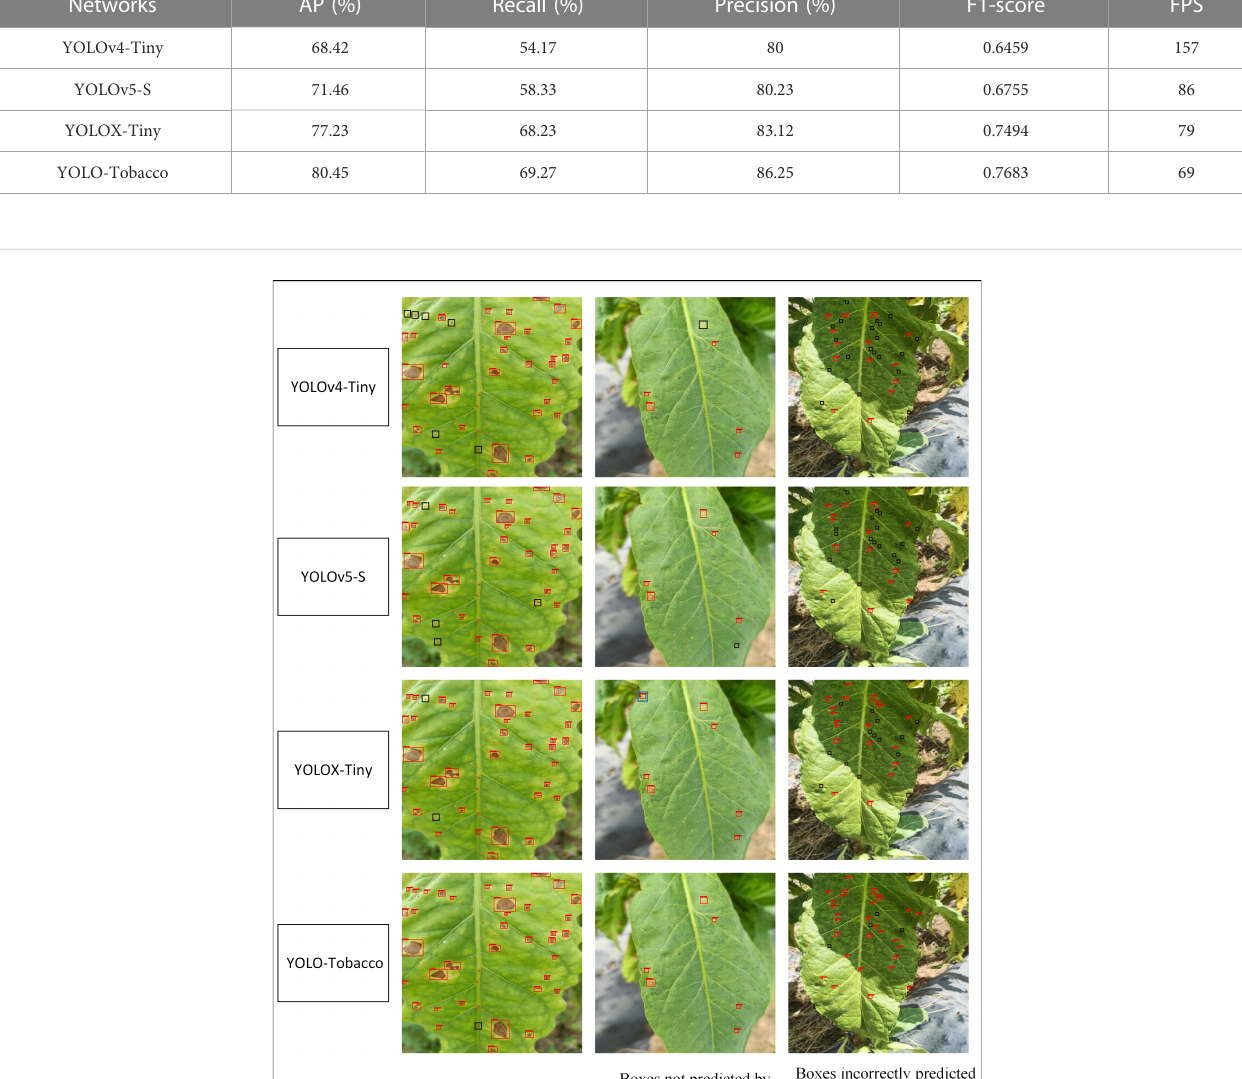
TABLE 4 Comparison results of different tiny detection networks with the con fi dence threshold is 0.5 and the IOU is 0.5. Networks